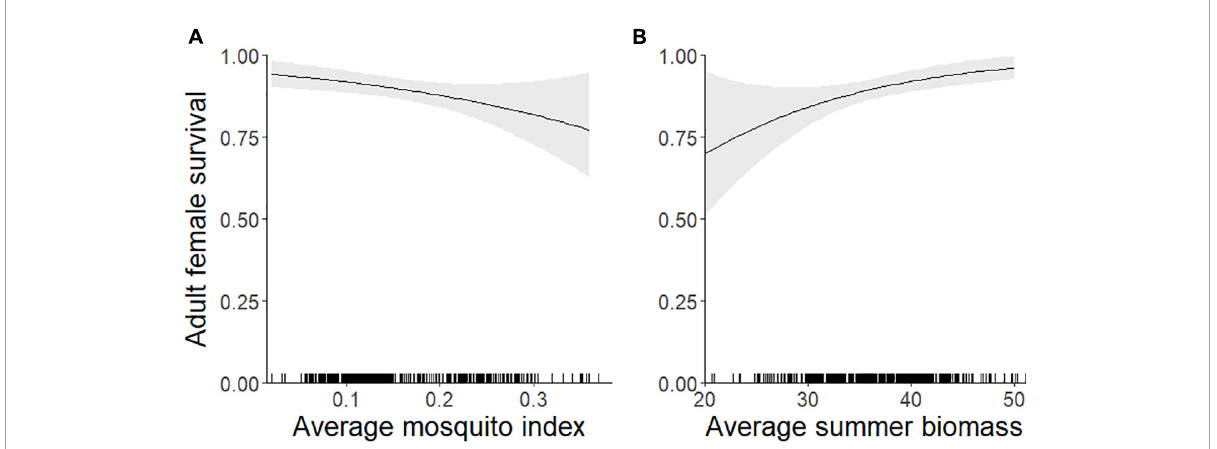
FIGURE5 Individual-level probability (and 95% confidence interval) of an adult female caribou surviving 9-months (1 September–31 May) modeled as a function of the previous summer’s (A) mosquito index during the mosquito harassment season, and (B) estimated forage biomass (g/m 2 ), Central Arctic Herd, Alaska, 2003–2020. The rug plot along the bottom of the figure depicts the distribution of data.